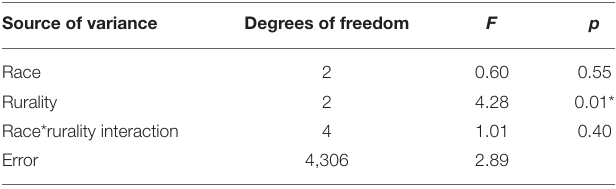
TABLE 4 | Two-way factorial analysis of variance results on the effect of race and rurality on differences in social technology use ( N = 4,315). Source of variance